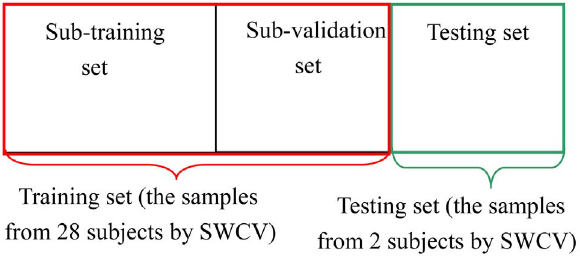
Figure 4. The division of feature samples using SWCV and 10- fold CV. The red rectangle denotes training set, whereas the green rectangle denotes testing set by the division of SWCV; Training set is further divided into sub-training set and sub-validation set by common 10-fold CV.